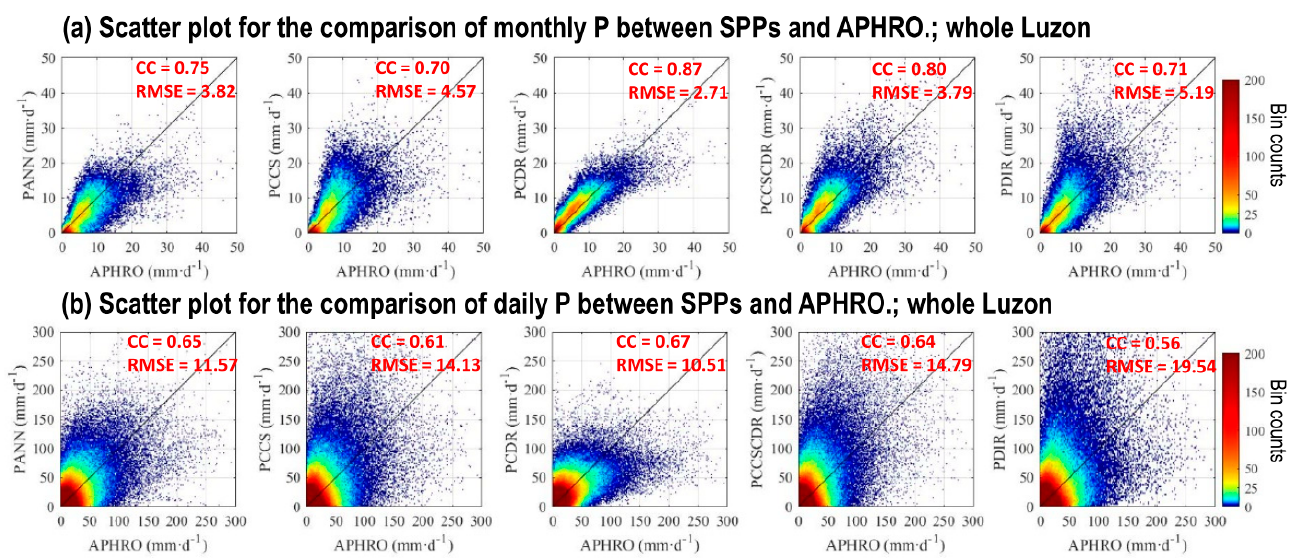
5b area-averaged at different elevations. area-averaged at different elevations.